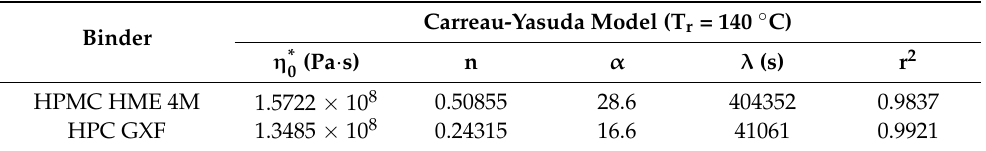
Table 5. Model parameters for master curves obtained by fitting complex viscosity vs. frequency curves for HPC GXF and HPMC HME 4M. Carreau-Yasuda Model (T r = 140 ◦ C) Binder η * (Pa · 0